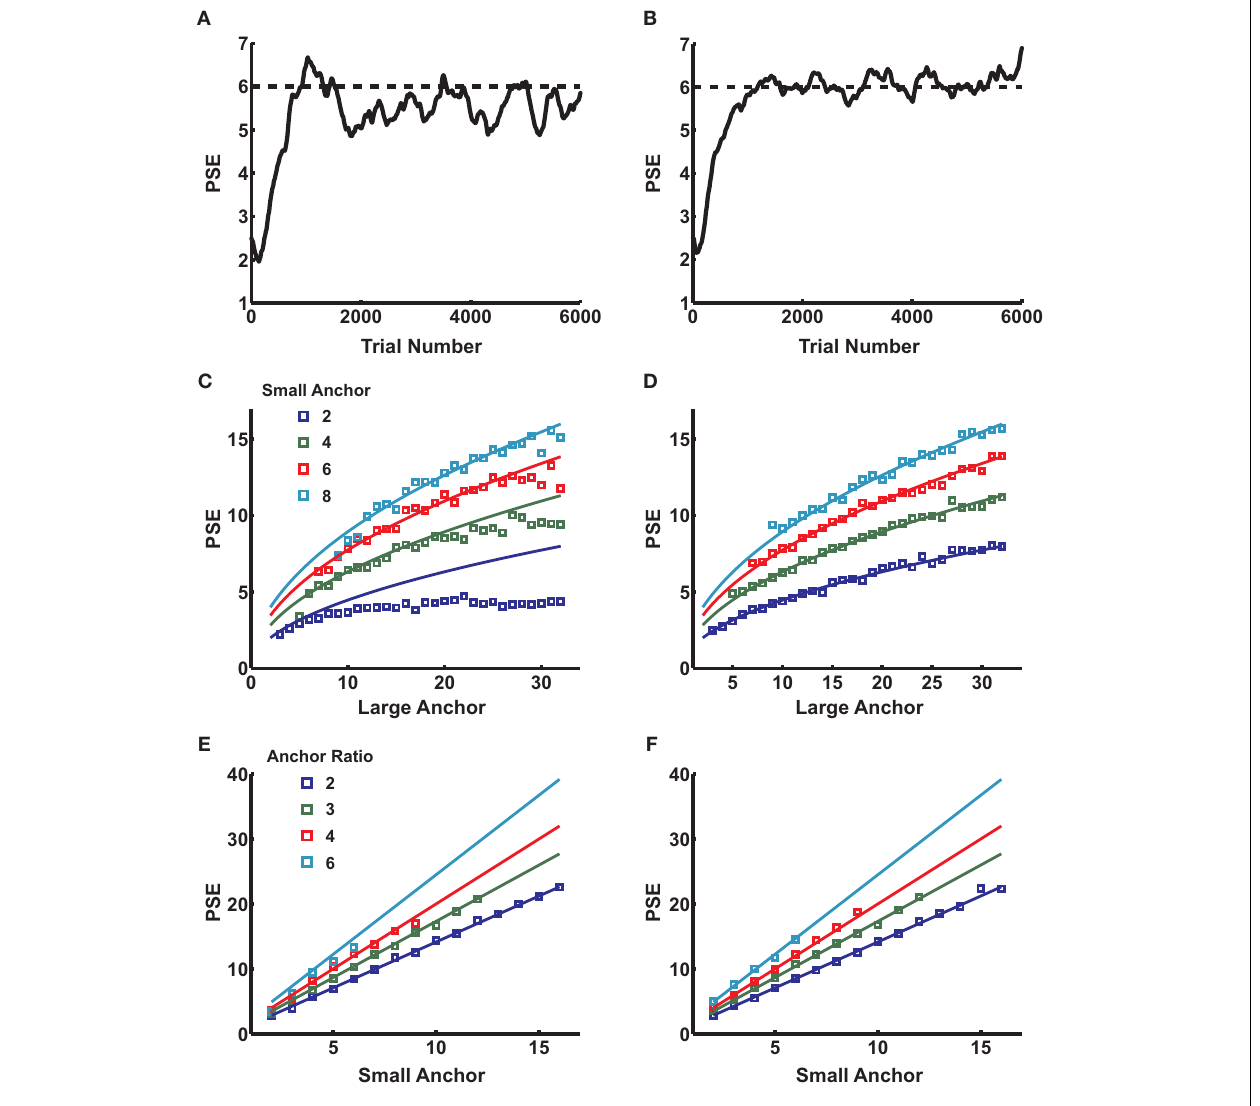
FIGURE 4 | A simple learning algorithm reproduces location of the PSE. (A) A sample learning curve for the fi rst 6000 trials of a bisection block with anchors 3 and 12. Dotted line marks the theoretical value of 6. Value learned by the algorithm with linear-hyperbolic inputs is around 5.3. (B) Same as (A) for the logarithmic model. Note that the mean PSE value is now equal to the geometric mean of the anchors. (C) PSE as a function of large anchor value for a series of small anchor values (different colors). Lines represent theoretical